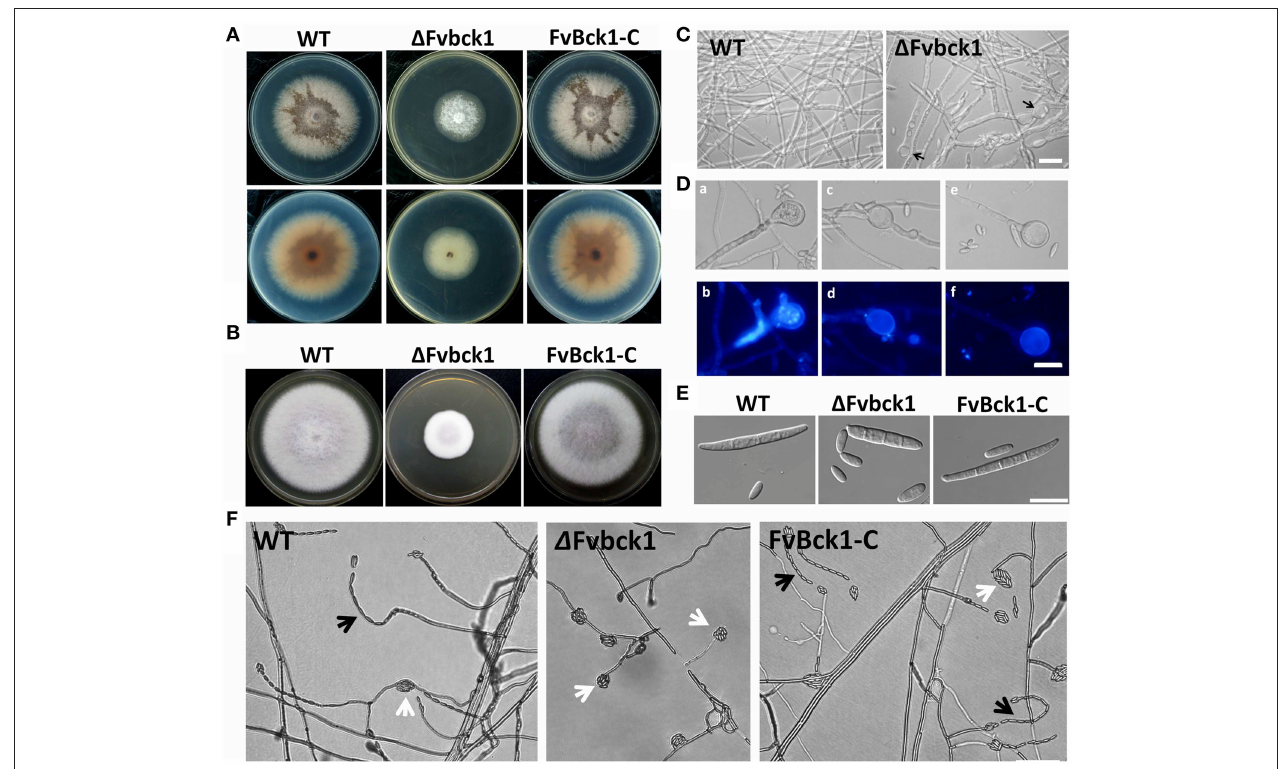
FIGURE 1 | Hyphal growth and conidiation phenotypes of wild-type (WT), FvBck1 deletion mutant ( 1 Fvbck1), and complementary (FvBck1-C) strains. (A) Strains grown on SJA plates for 5 days. Upper panels are top view, and lower panels are bottom view. (B) Strains grown on CM plates for 5 days. (C) Hyphal morphology of WT and 1 Fvbck1 strains grown in liquid CM medium for 3 days. The black arrows indicate swollen structures in the hyphae of 1 Fvbck1 strain. Bar = 50 µ m. (D) Detailed view of swollen structures in 1 Fvbck1 hyphae. Hyphae were stained with 10 µ g/ml 4 ′ ,6-diamidino-2-phenylindole (DAPI) and examined under differential interference contrast (DIC) (a,c,e) microscopy or UV light (b,d,f) . Bar = 20 µ m. (E) Conidiation of each strain grown in MBJ medium for 7 days under white and UV light. Bar = 20 µ m. (F) Microconidiation of each strain grown on solid modified Bilai’s medium for 5 days. The black and white arrows indicate microconidial chain and false heads, respectively. Bar = 50 µ